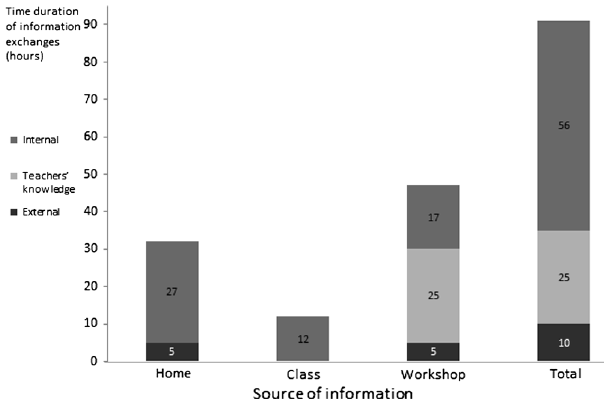
FIG. 5. Workshop C (cognitive apprenticeship): Information interchanges by source of information and location.